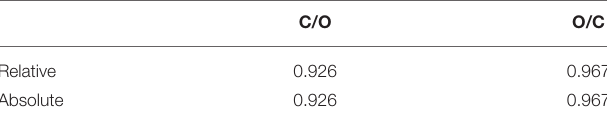
TABLE 4 | Relative and absolute generalizability